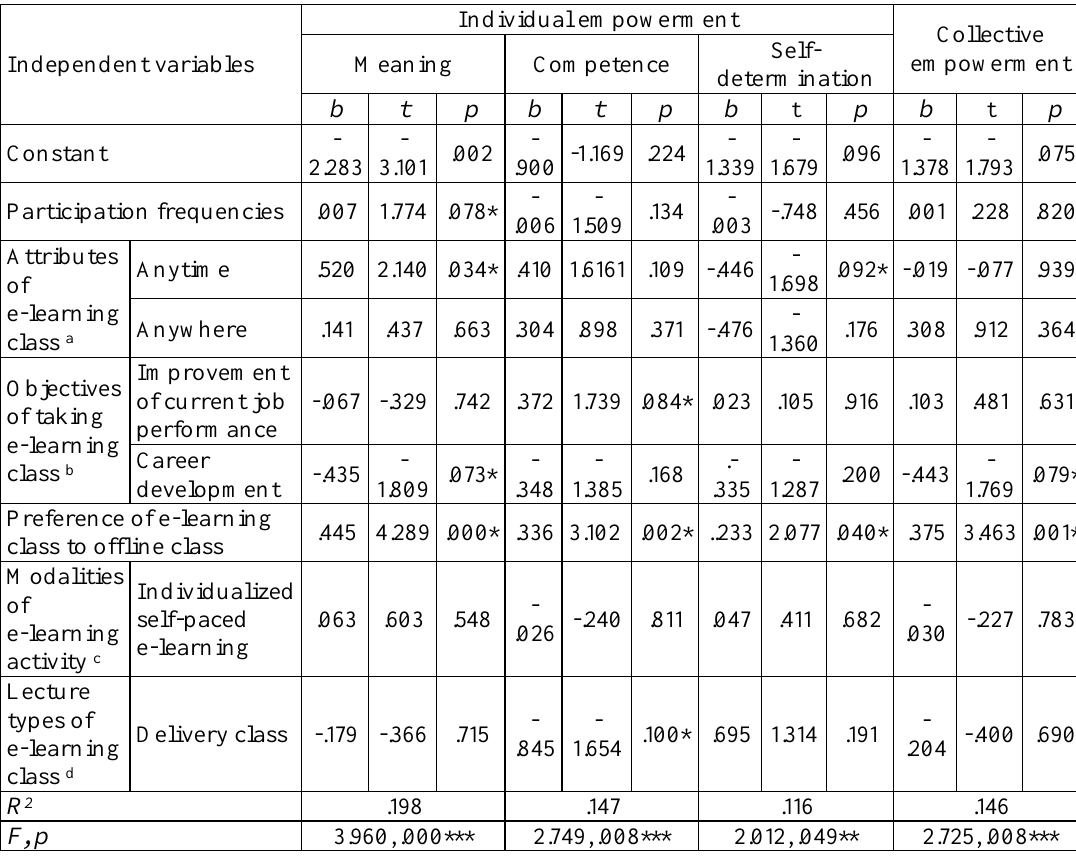
Individual empowerment